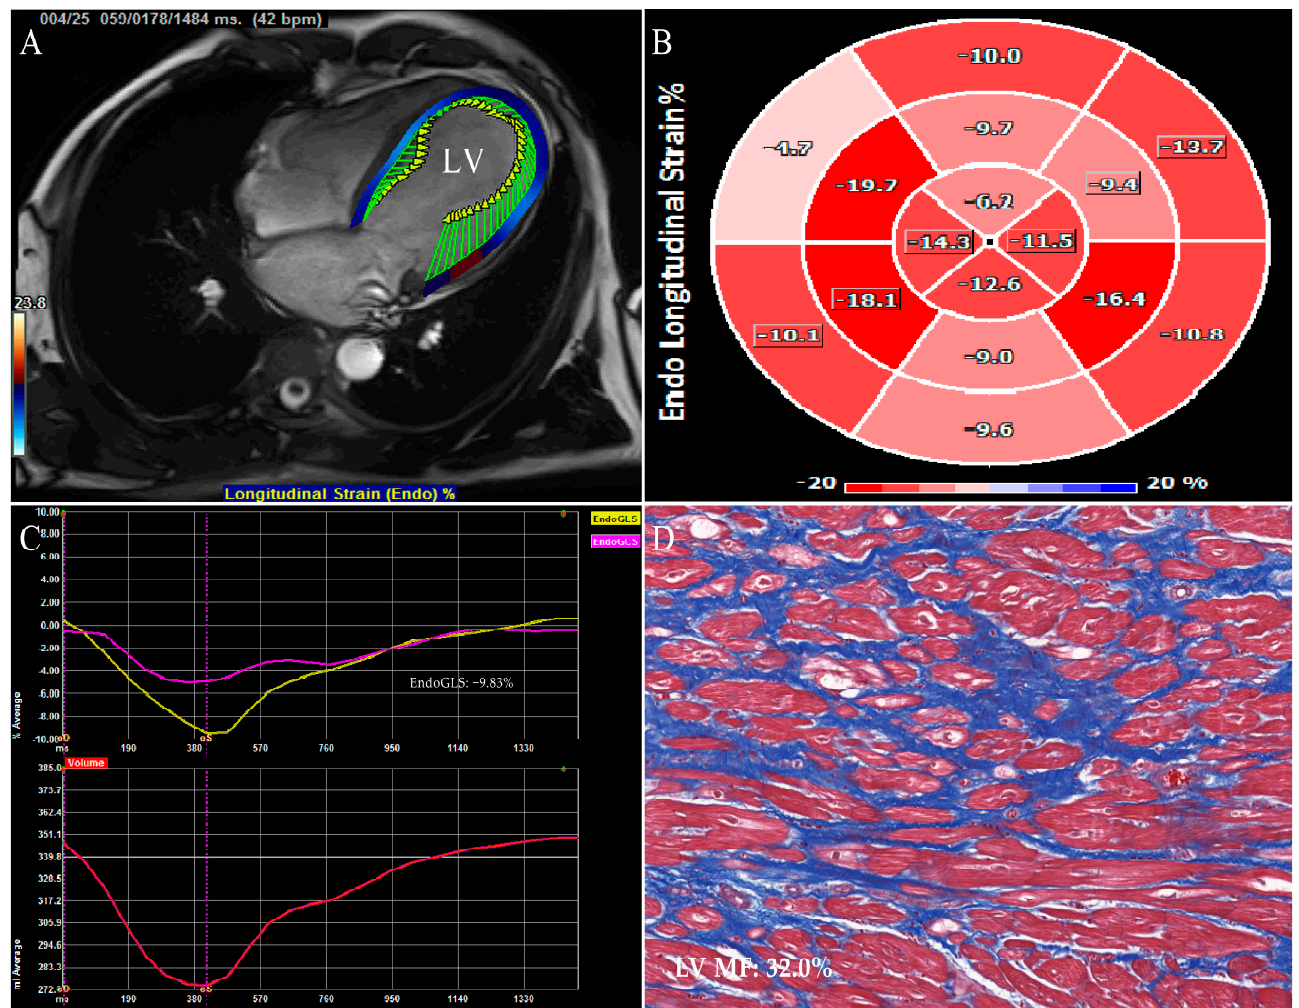
Figure 3. CMR − FT strain images of left ventricle in a DCM patient who underwent the heart transplantation. ( A ) LV endocardial border outlining and tracking. ( B ) Bulls − eye plot of LV segmental longitudinal strain. ( C ) LV global longitudinal strain (yellow curve) and global circumferential strain (pink curve). ( D ) Example of LV myocardial samples stained with Masson’s staining (original magnification ×200). CMR − FT: cardiac magnetic resonance feature tracking; DCM: dilated cardiomyopathy; other abbreviations as in Figures 1 and 2.